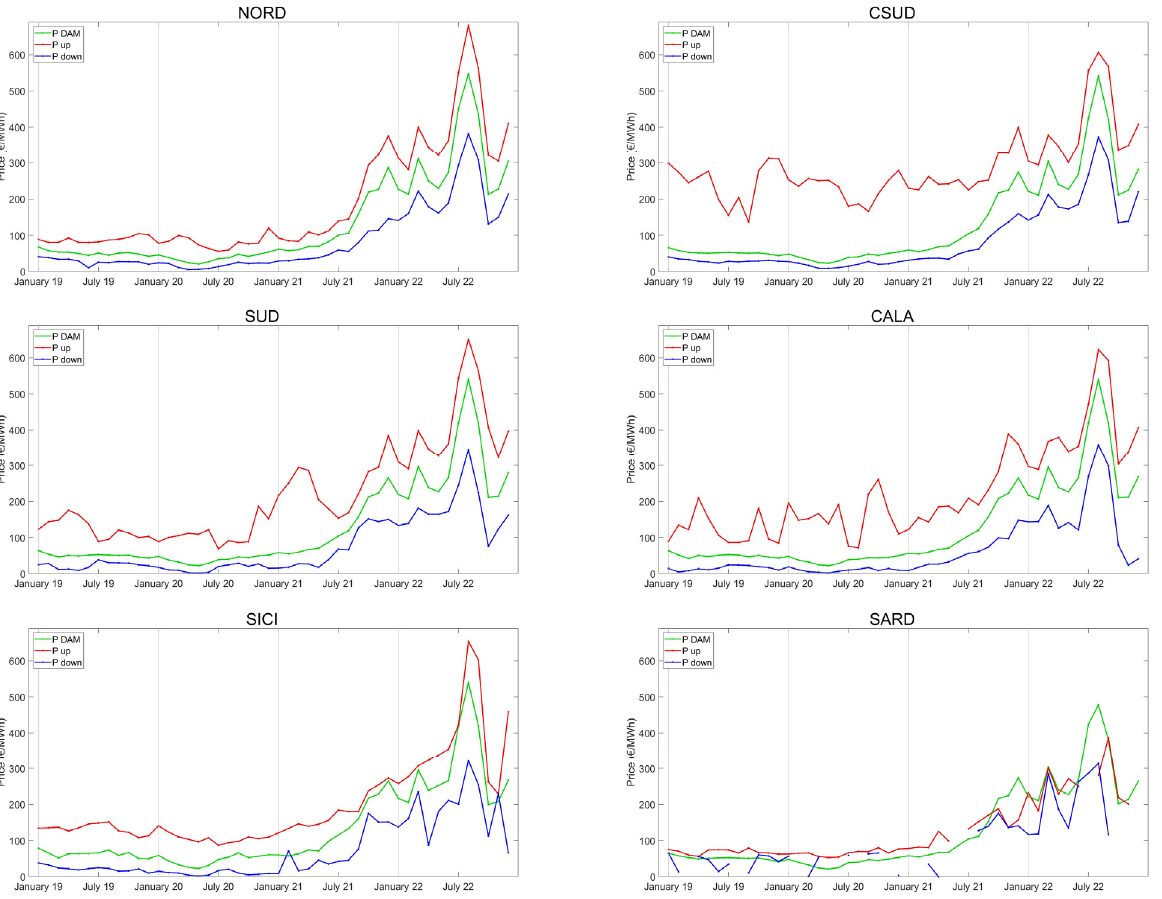
Figure 3. Trend of average monthly prices of P DAM (green), P up (red), and P down (blue). (NORD=North; SUD=South; CSUD=Center ‐ South; CALA=Calabria; SARD=Sardinia; SICI=Sicily).